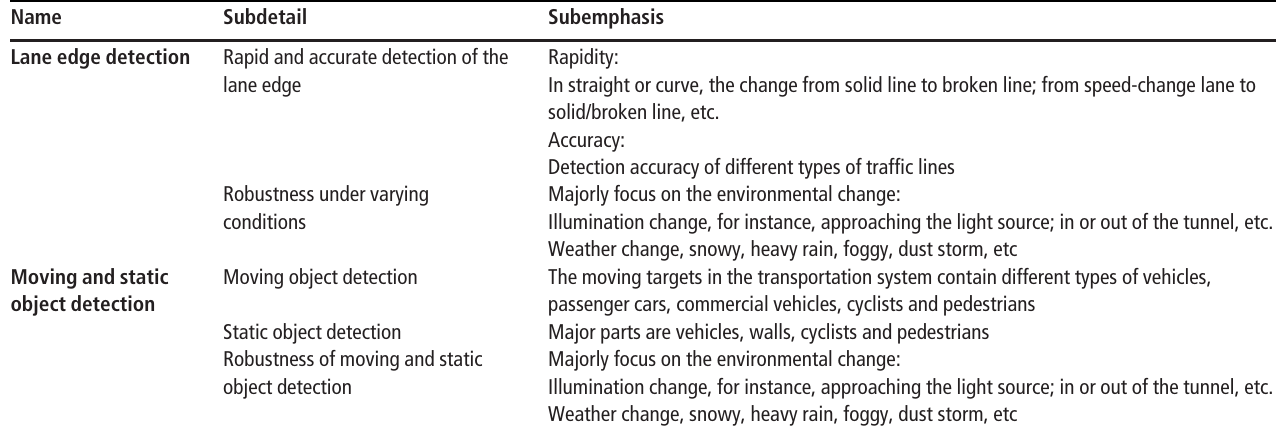
Table 1 Details of the perception dimension Name